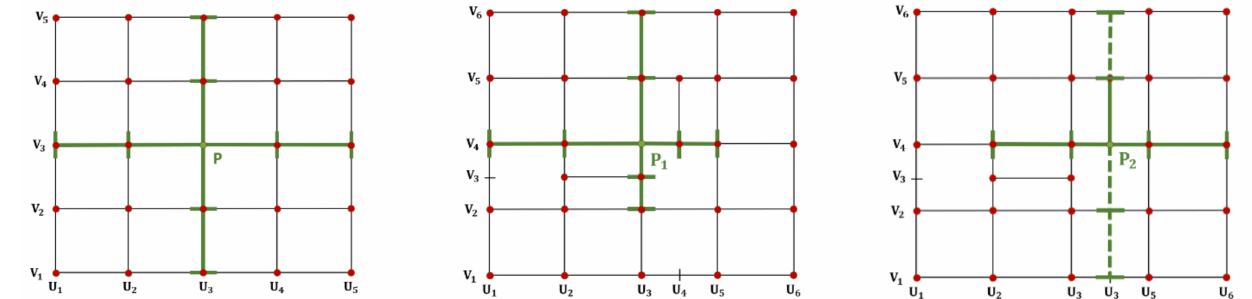
Figure 2. Illustration of the concept of blending functions and control points refinement. Left : Control point P with its associated knot quintuples in both directions. Refinement and new control points P1 ( middle ) and P2 ( right ) and their associated knot